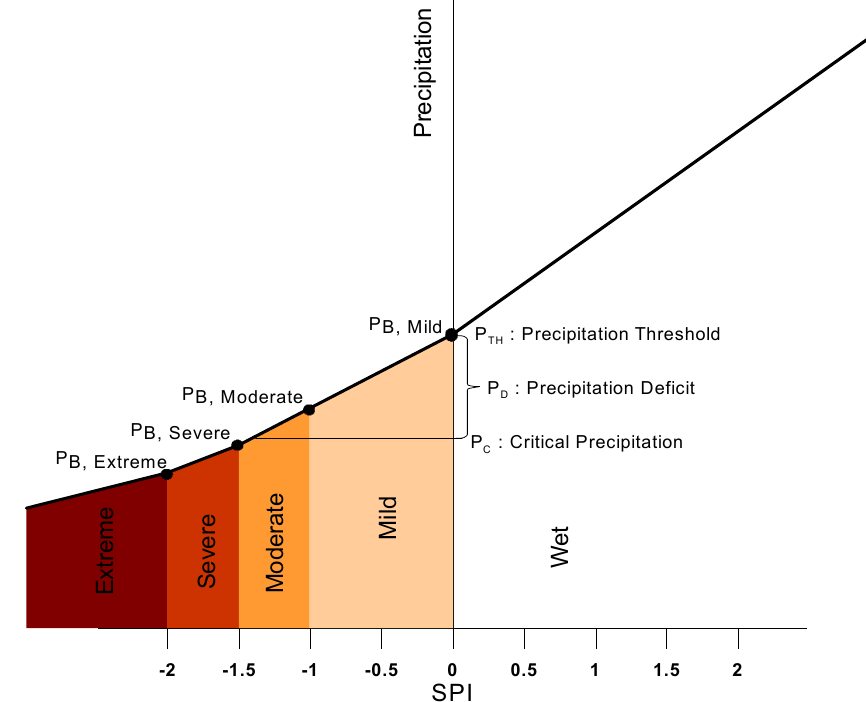
Figure 6. Definition of precipitation threshold, boundary precipitation and critical precipitation.